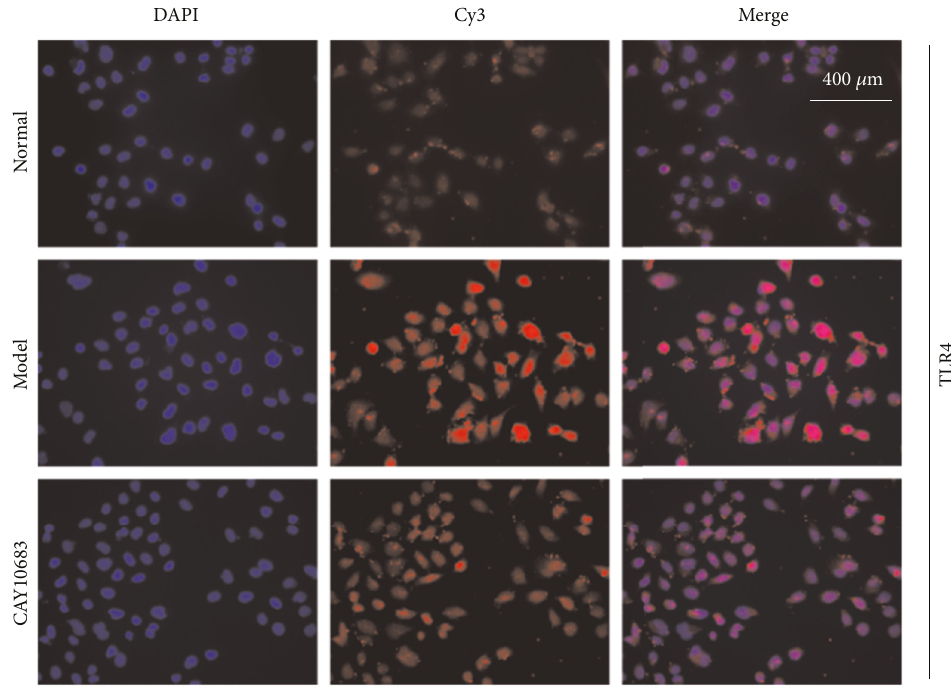
Figure 3: The IF method was used to detect the protein expressions of TLR4 in LPS-stimulated NCM460